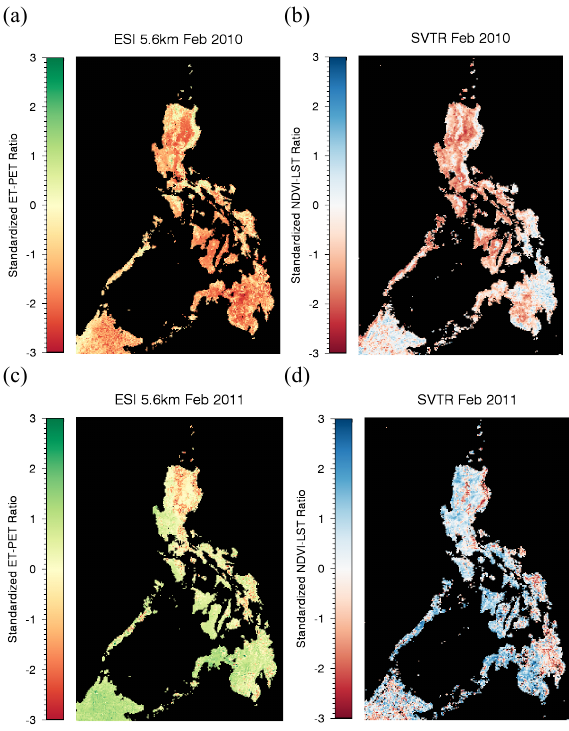
Figure 1. Maps of (a) ESI [5.6 km] and (b) SVTR [5.6 km] for February 2010 and (c) ESI [5.6 km] and (d) SVTR [5.6 km] for February